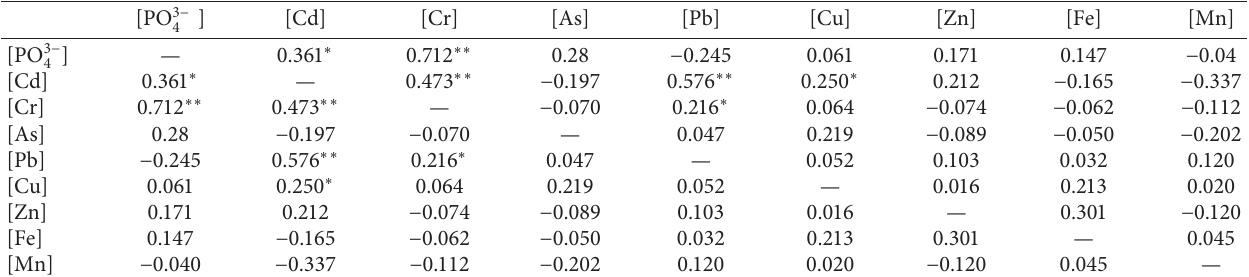
Table 5: Correlation matrix of phosphate and heavy metal concentrations of soil in paddy grown agricultural areas in selected sampling areas.